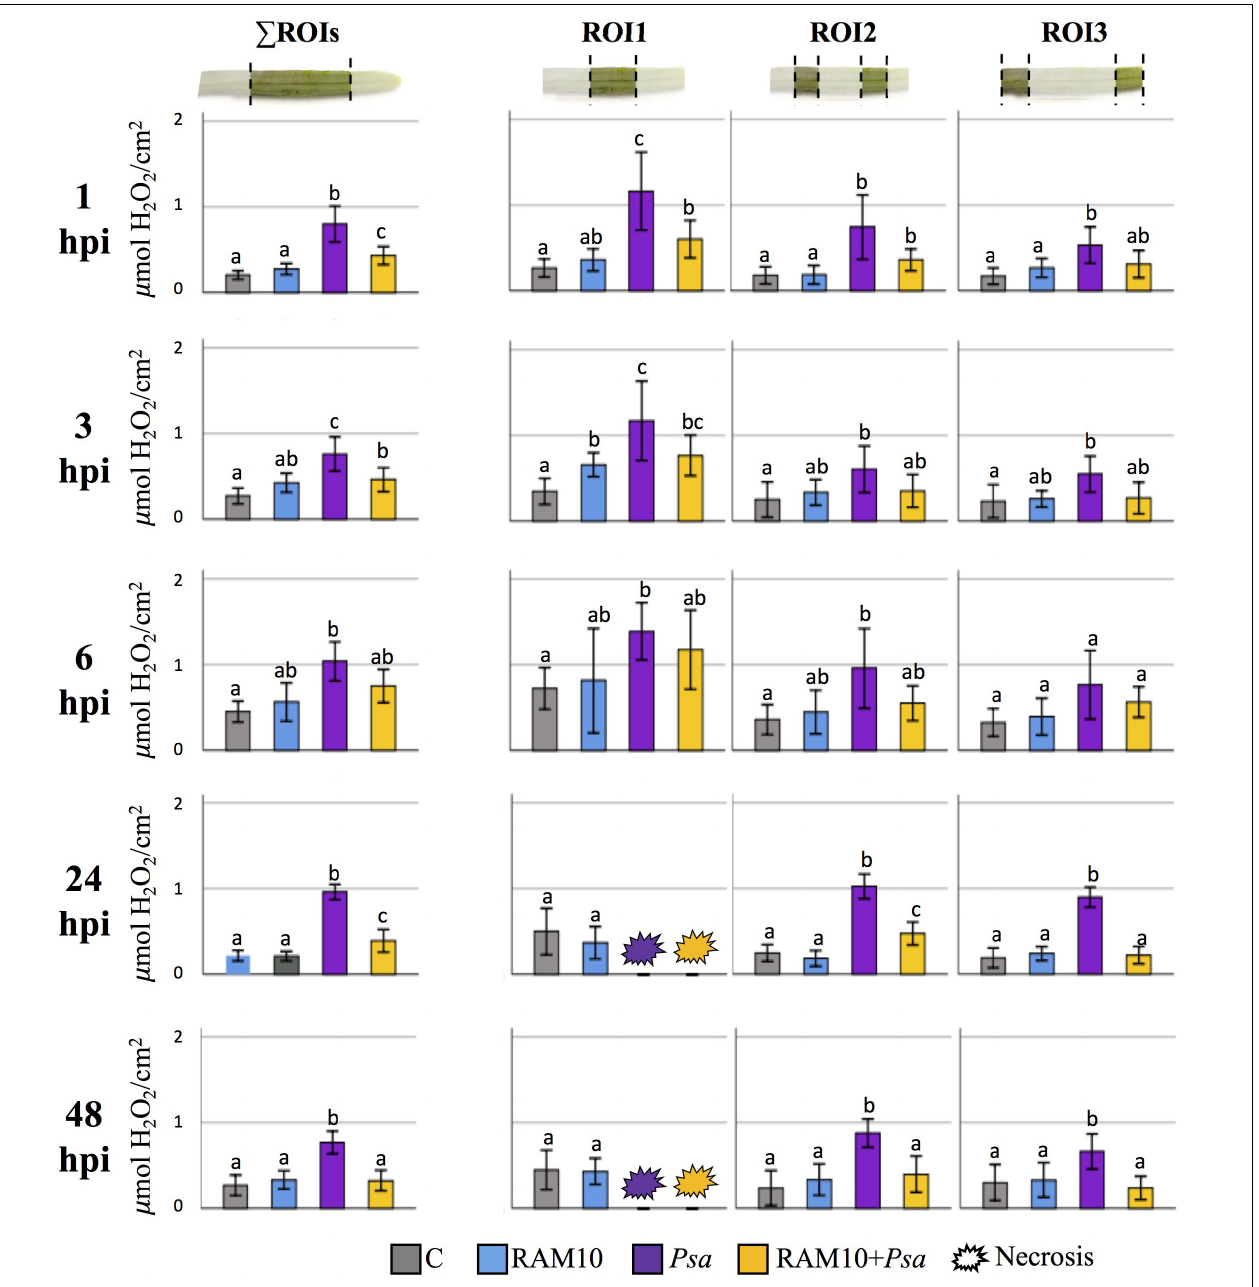
FIGURE 4 | Relative H 2 O 2 concentration in the entire selected area ( P ROIs) in C, RAM10, Psa and RAM10 + Psa plants from 1 to 48 h post Psa inoculation. The three graphs next to each P ROIs represent H 2 O 2 concentration at increasing distances from the inoculation point (ROI1, ROI2 and ROI3) in C, RAM10, Psa and RAM10 + Psa plants from 1 to 48 h post Psa infiltration. Different letters indicate statistically significant differences between groups (mean ± 95% CI, corrected for multiple comparisons; Games-Howell non-parametric test, p <